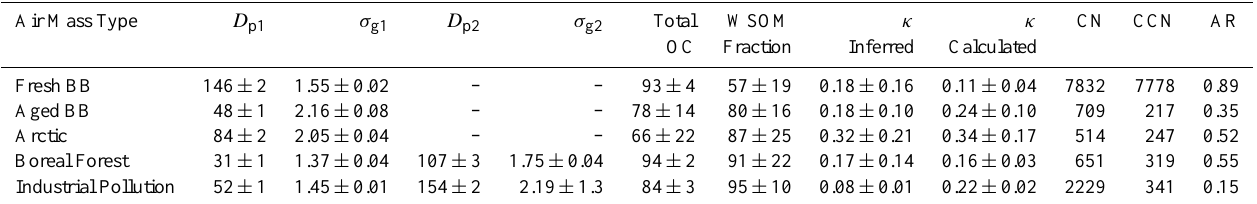
Table 1. Summary of aerosol microphysical and chemical properties for each source type. Median size ( D p , nm) and standard deviation ( σ g ) are from lognormal fits to the merged UHSAS and SMPS distributions. Total volume of Organic Carbon (OC) and the Water-soluble Organic Matter (WSOM) fraction of the OC are percentages calculated from total HR-ToF-AMS and PILS-WSOC mass loadings (Sect. 2.3). Inferred particle hygroscopicity, κ , is from measured CCN and size distributions while calculated κ is from AMS and WSOM composition (Sect. 3.1). Median CN and CCN concentrations are reported in cm − 3 at STP. CCN and Activation Ratio (AR, CCN/CN) are reported at 0.55% instrument supersaturation. Biomass burning is abbreviated as